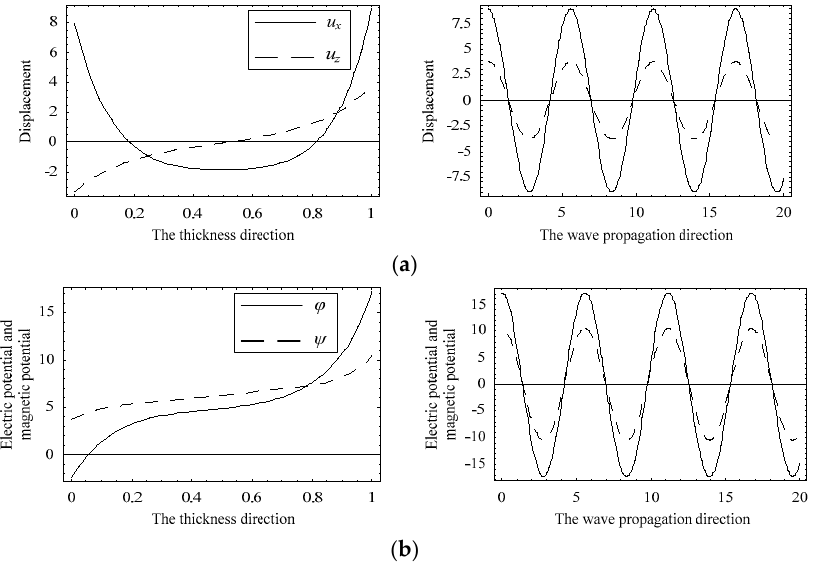
Figure 12. Distributions of the physical quantities when Ω = 1.01911, Ψ = 0.17938. ( a ) displacement distribution, ( b ) electric potential and magnetic potential distribution.